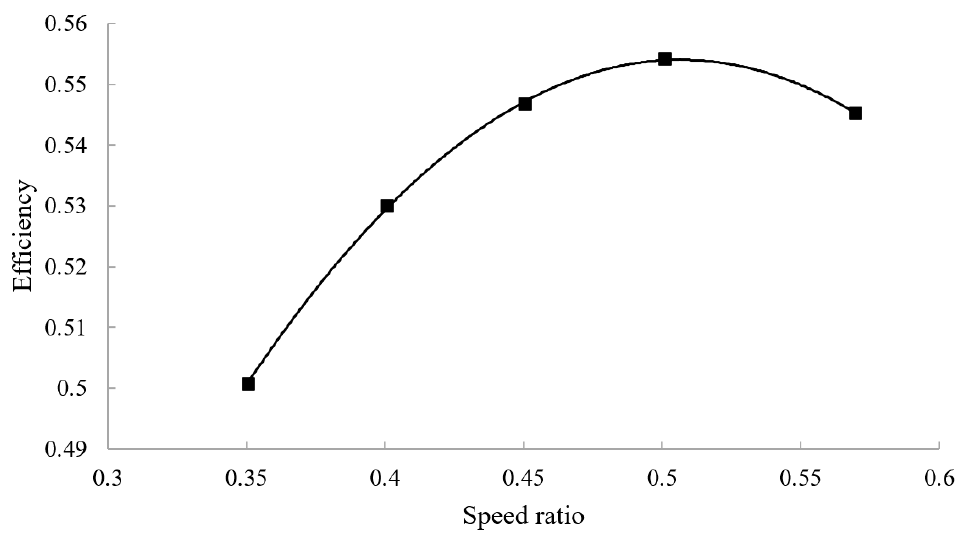
Figure 7. Efficiency against speed ratio for the imported turbine.